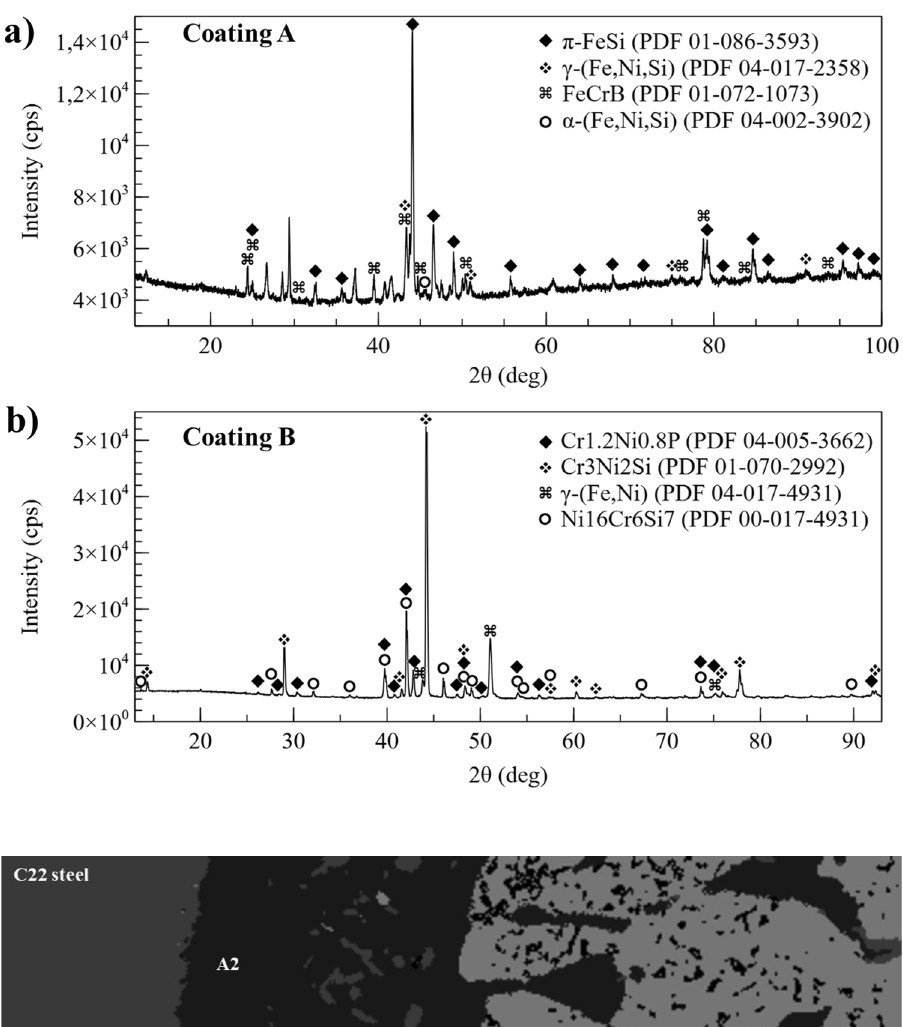
Fig. 4 XRD patterns of coat- ings A ( a ) and B ( b )